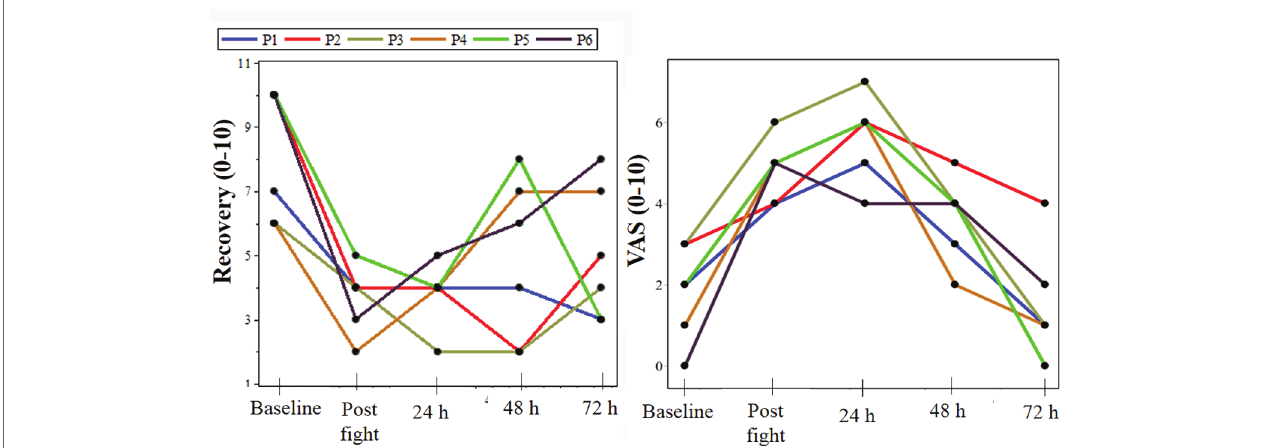
FIGURE 2 | Clinical outcomes, represented by pain and perception of recovery. h, hours; P, parathlete; parathletes I and II were world champions in their respective categories; VAS, analogic visual scale; U/L, units per liter.